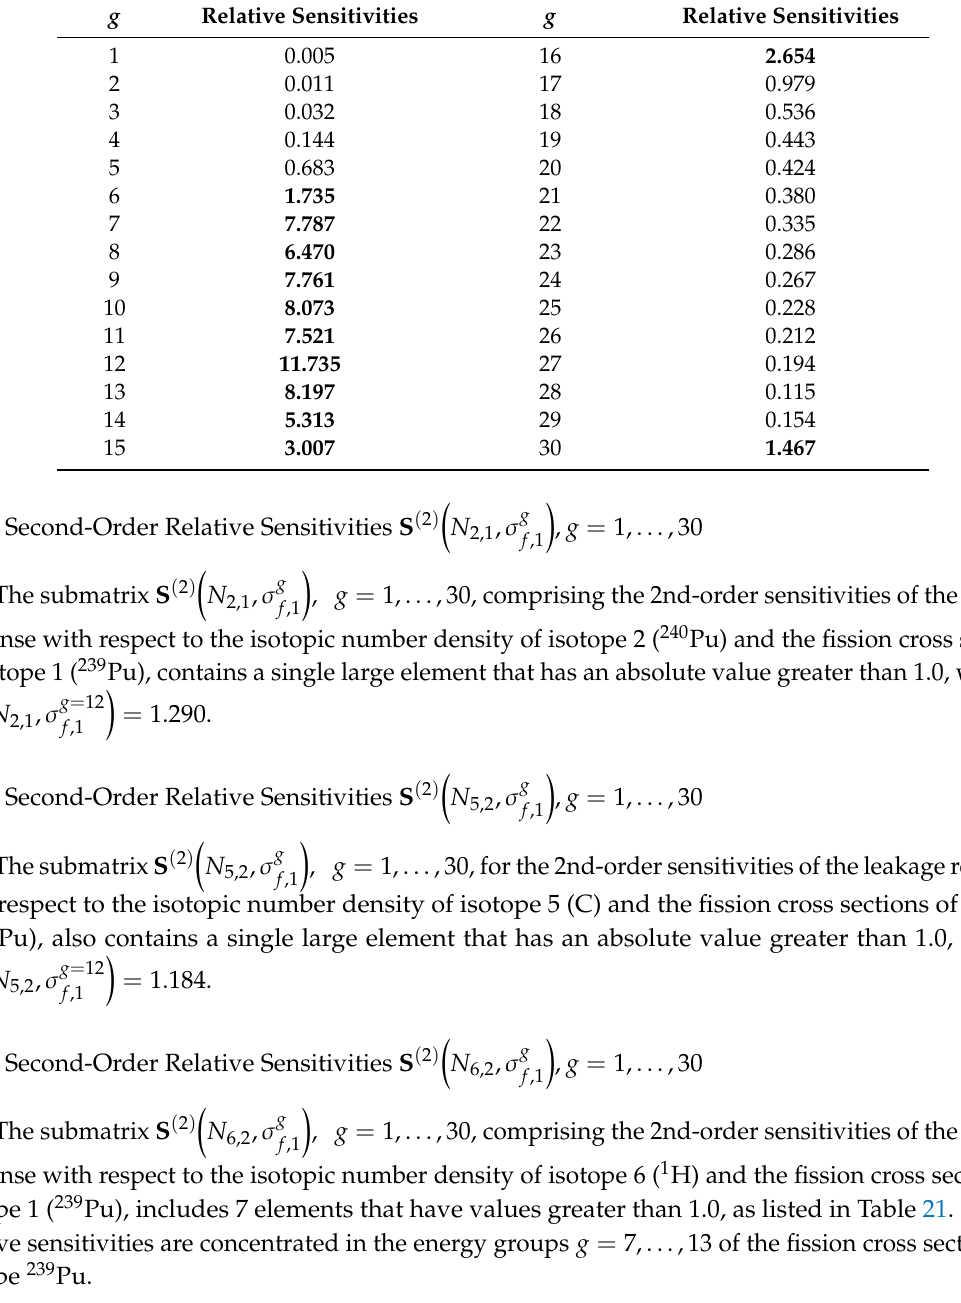
Table 20. Second-Order Relative Sensitivities S ( 2 )